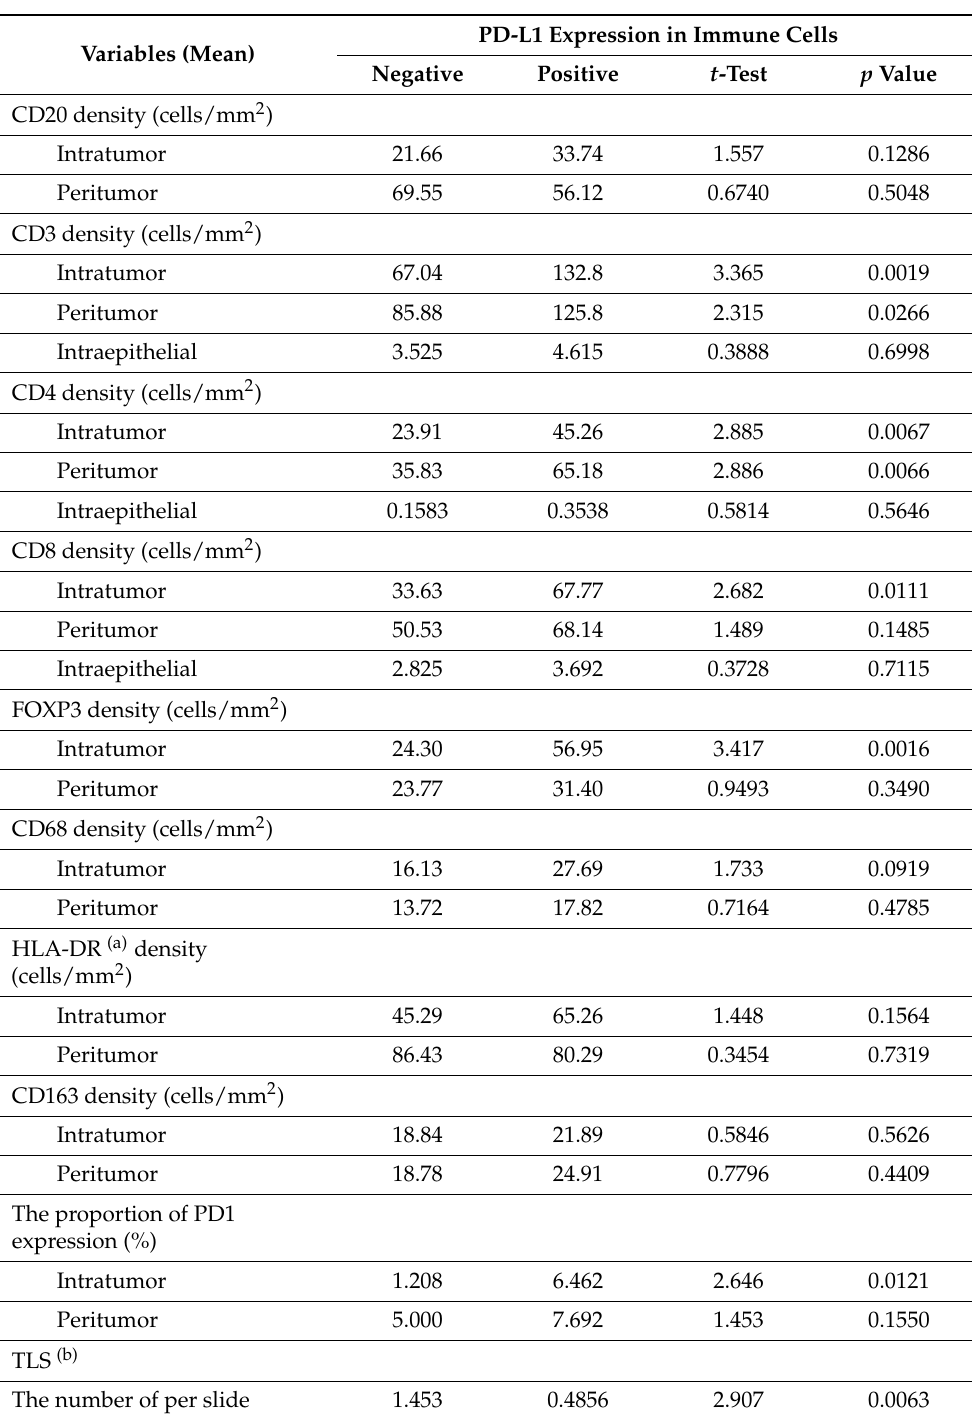
Table 3. Correlation between the PDL1 expression in immune cells and immune characteristics in